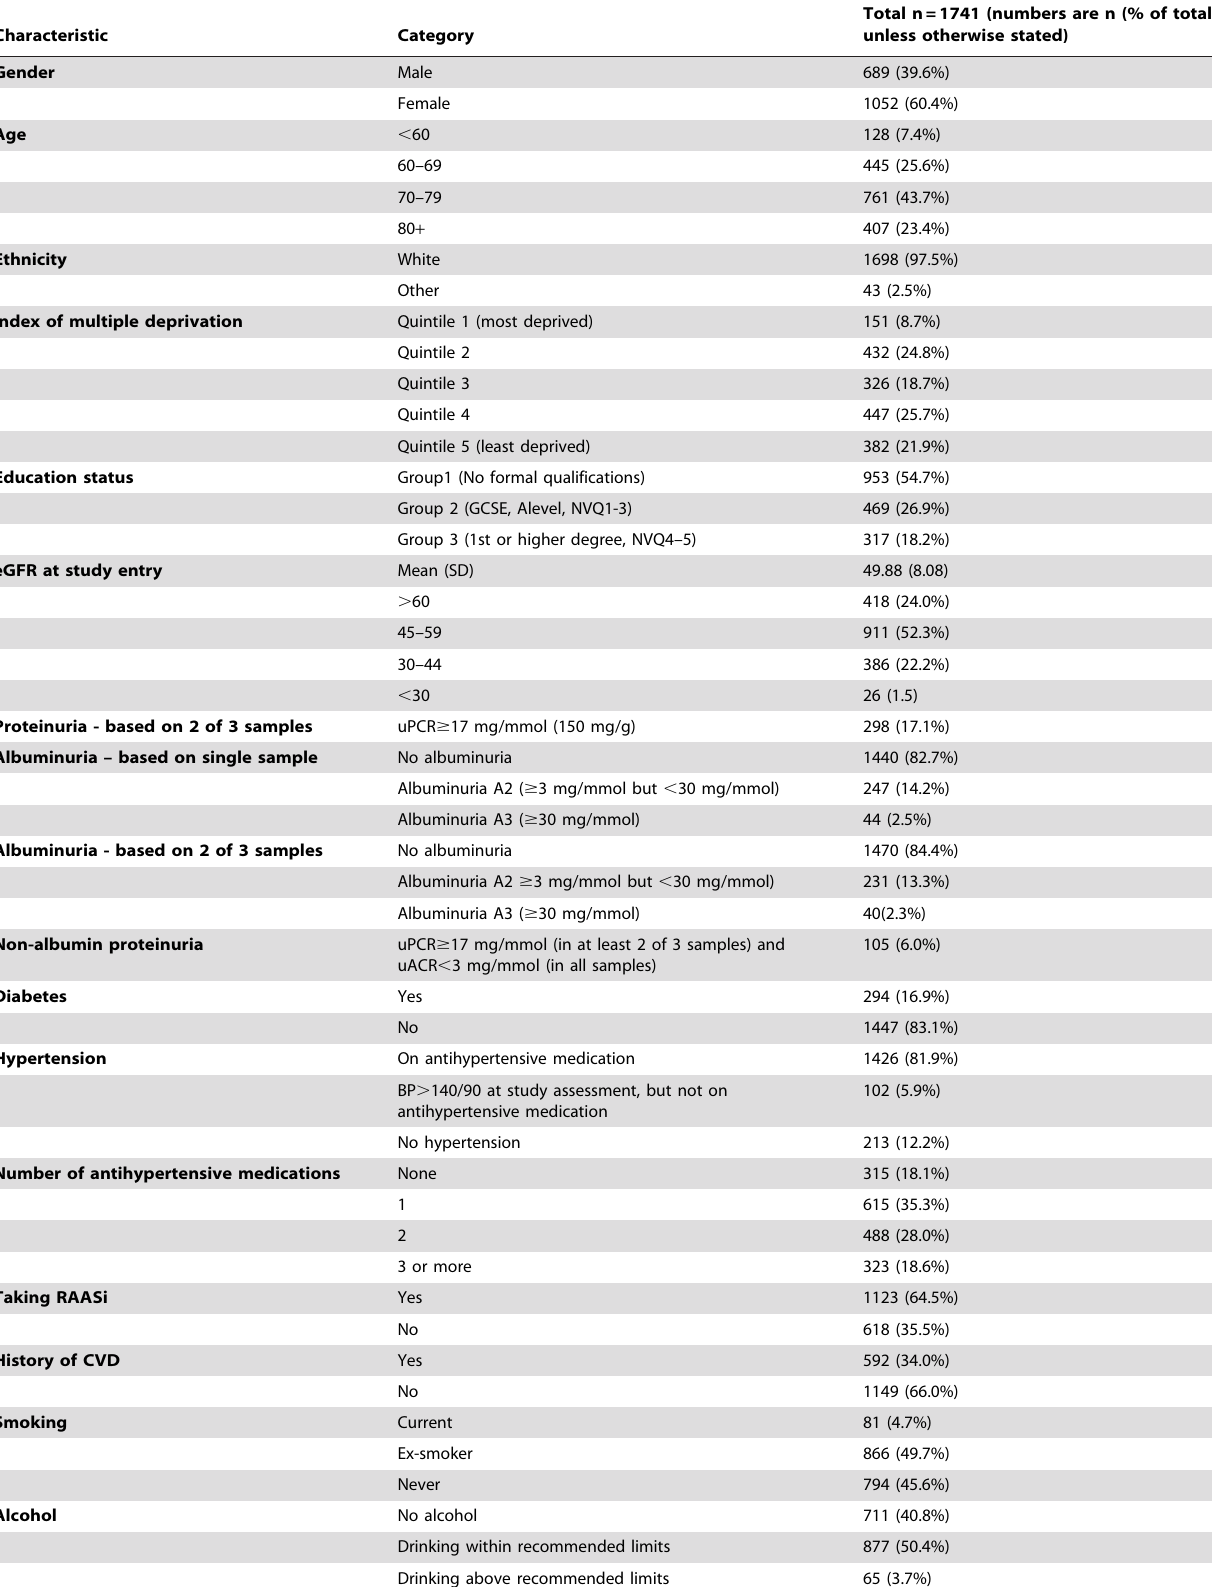
Table 1. Characteristics of people in the Renal Risk in Derby cohort.